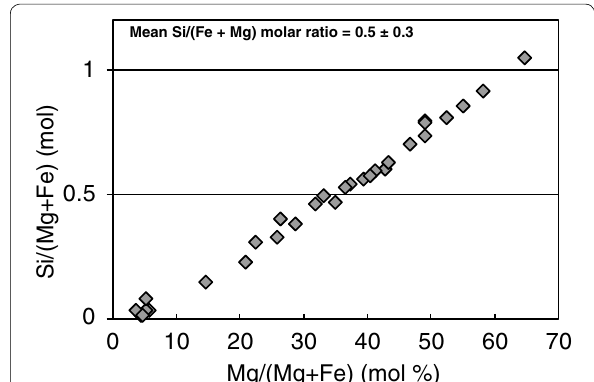
Fig. 3 EPMA analyses of a symplectite. EPMA analyses were randomly made across the lamellar zone of the symplectite shown in Fig. 2a,